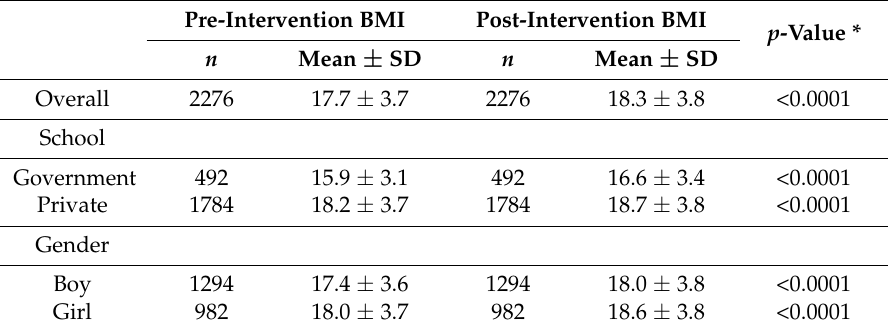
Table 2. Pre-post body mass index of ORANGE study participants, overall and by school type and